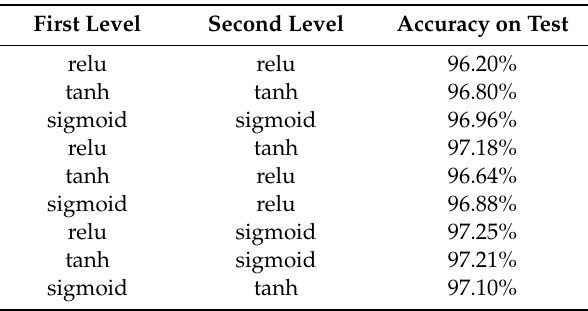
Table 4. Accuracy for di ff erent activation